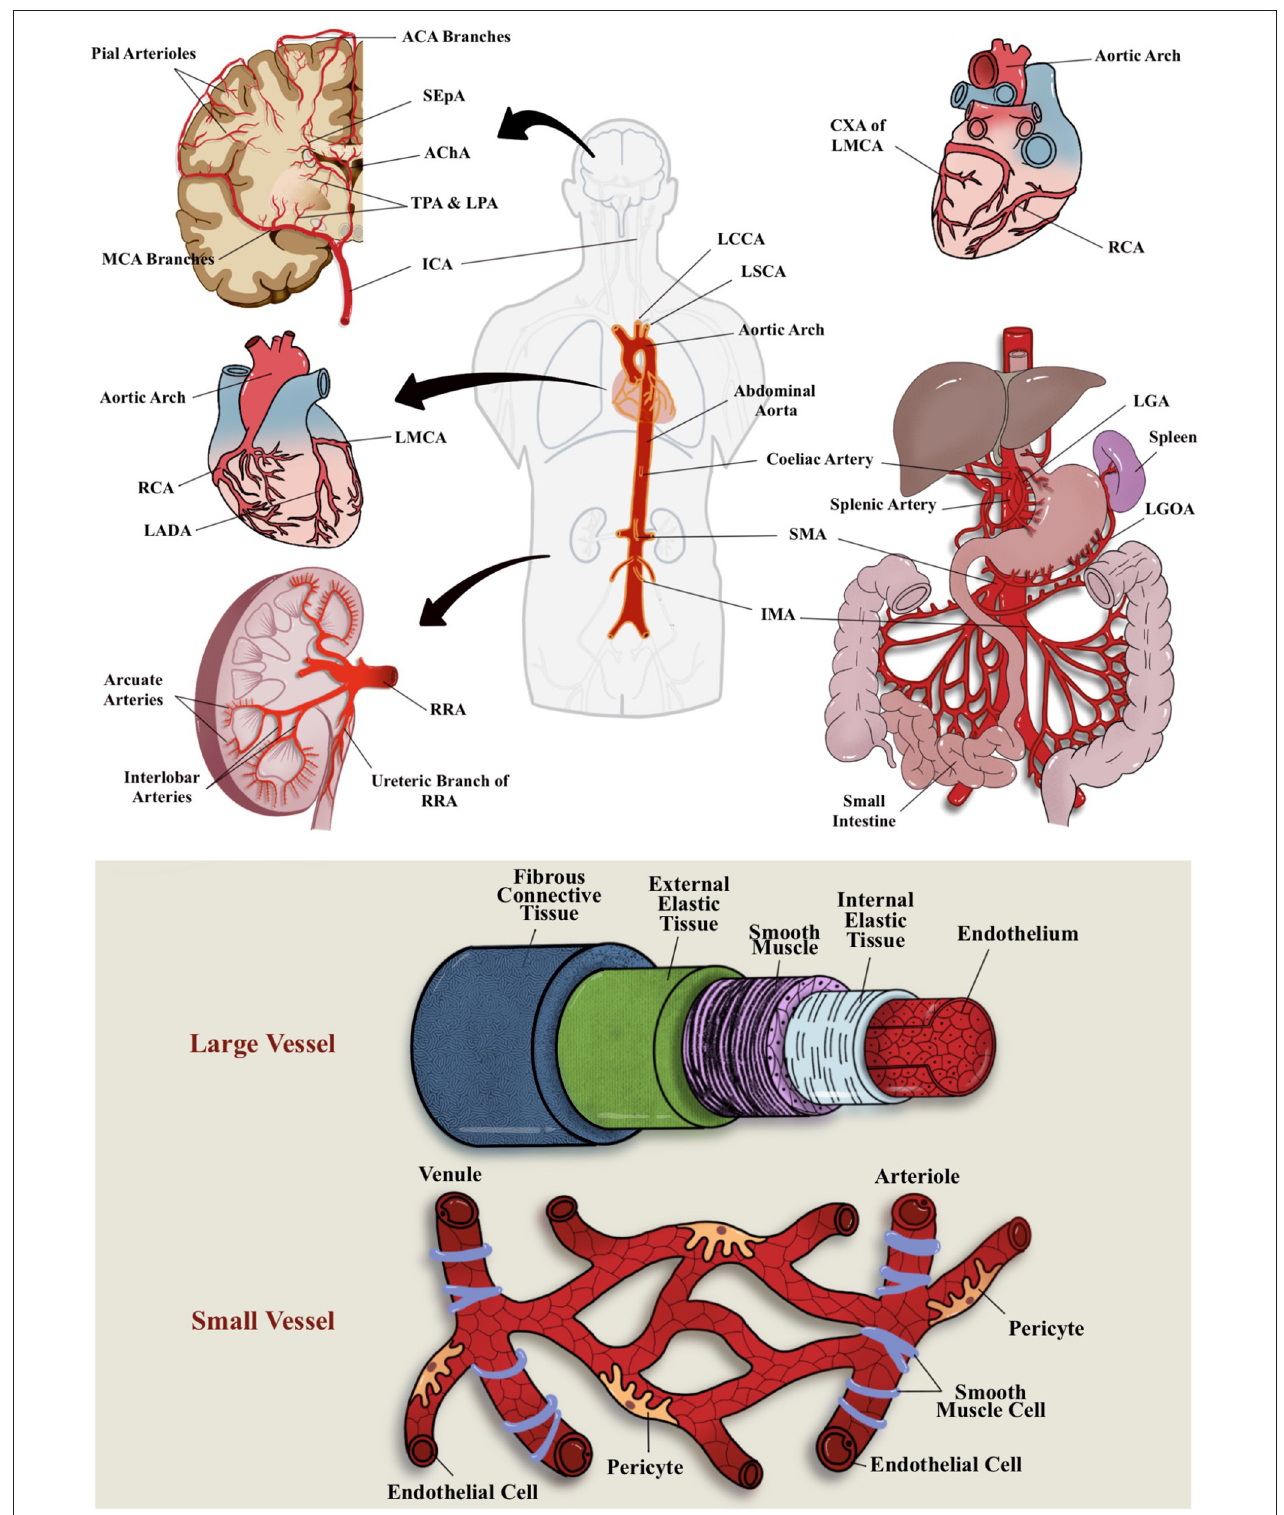
FIGURE 1 | Vascular blood (arterial) supplies to the brain, heart, GIT, and kidney and differential structure between large and small vessel. Most of these organs receives their blood supply locally or from the abdominal aorta. ACA, anterior cerebral arteries; AChA, anterior choroidal arteries; CXA, circumflex artery; ICA, internal carotid artery; IMA, inferior mesenteric arteries; LADA, left anterior descending artery; LCCA, left common carotid artery; LGA, left gastric artery; LGOA, left gastro-omental artery; LMCA, left main coronary artery; LPA; lenticulostriate perforating arteries; LSCA, left subclavian artery; MCA, middle cerebral artery; RCA, right coronary artery; RRA, right renal artery; SEpA, subependymal arteries; SMA, superior mesenteric artery; TPA, thalamic perforating arteries.